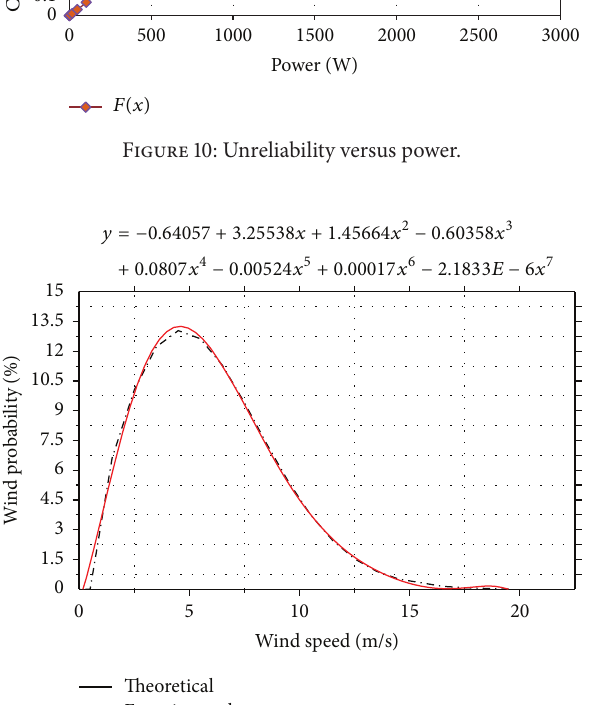
Figure 11: Wind probability at different wind